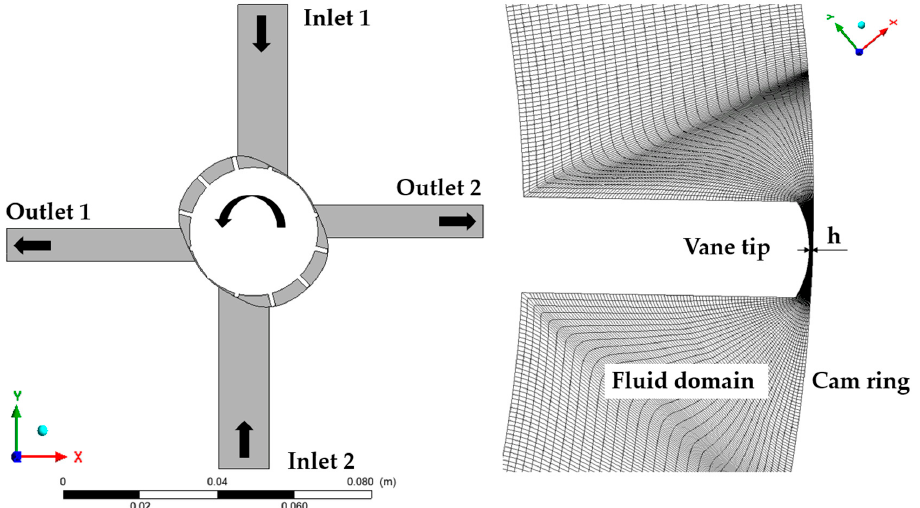
Figure 2. 2D vane pump model and meshing details of the rotor.